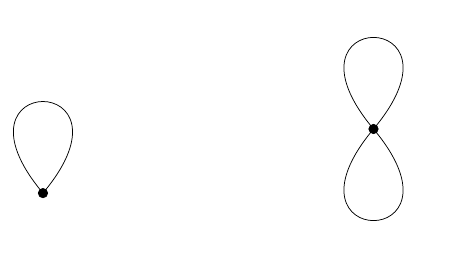
Figure 2 . The only two vacuum 2PI diagrams occurring in the O ( N ) model at large N . The tadpole on the left has a two-valent mass vertex, while the figure-eight on the right has a λ vertex.